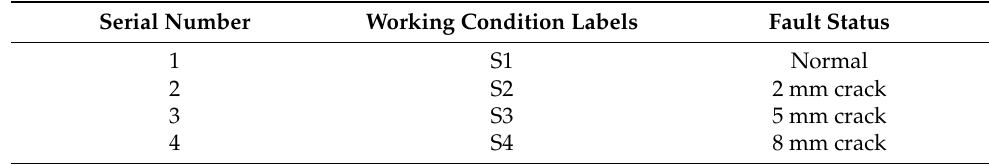
Figure 8. Gear reducer test stand and sensor layout.